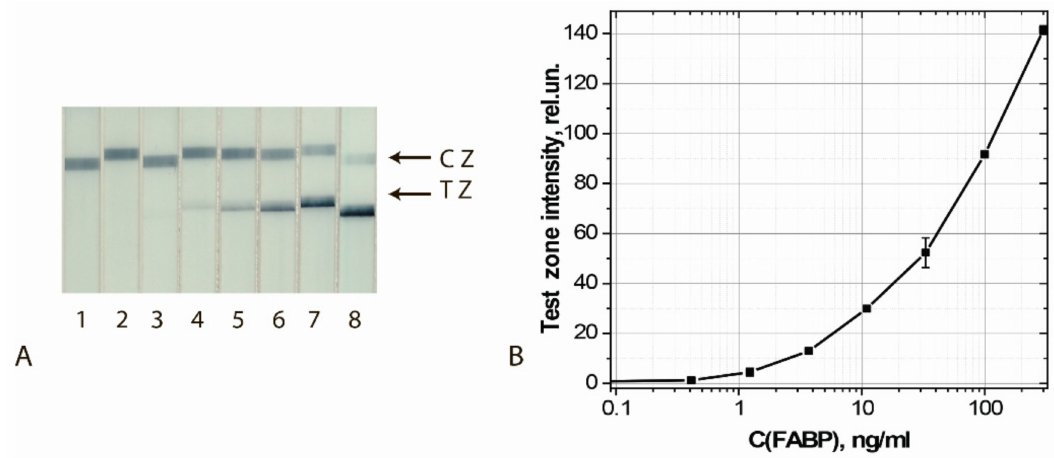
Figure 10. Detection of FABP in buffer by LFIA using the conjugate GNFs (20/0.12/0.2) Ab6/FABP. ( A ) Appearance of test strips after analysis of samples containing 0 (1), 0.4 (2), 1.2 (3), 3.7 (4), 11 (5), 33 (6), 100 (7), and 300 (8) ng/mL of FABP. ( B ) Dependence of the coloration intensity of the TZs on the concentration of FABP.